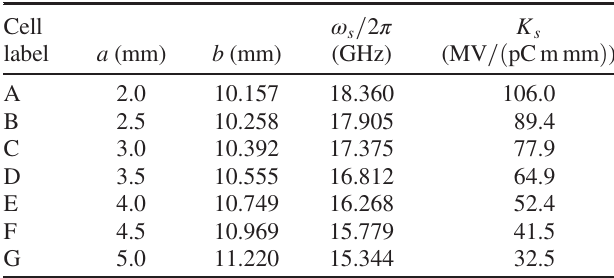
TABLE II. The iris radii a , cell radii b , synchronous dipole = 2 π and the synchronous dipole kick K frequency ω s fiducial cells of the XARA X -band structure. Intermediate values can be interpolated using this